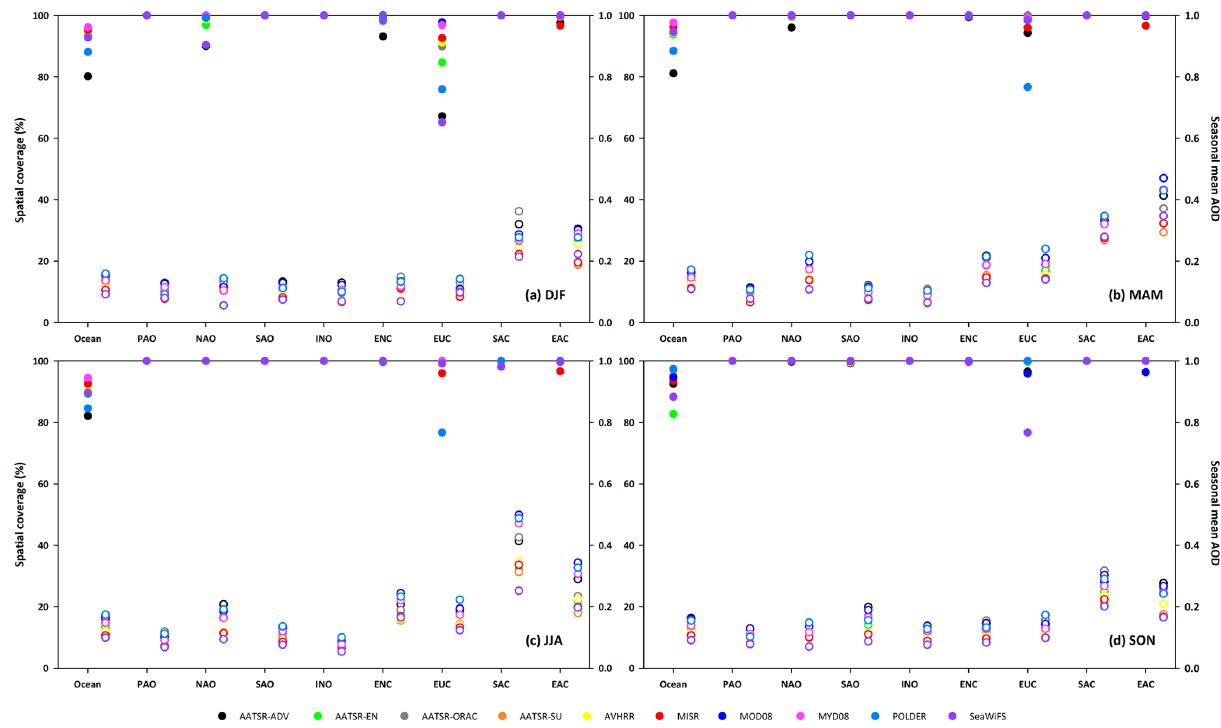
Figure 11. Same as Fig. 10 but for each customized region over ocean.